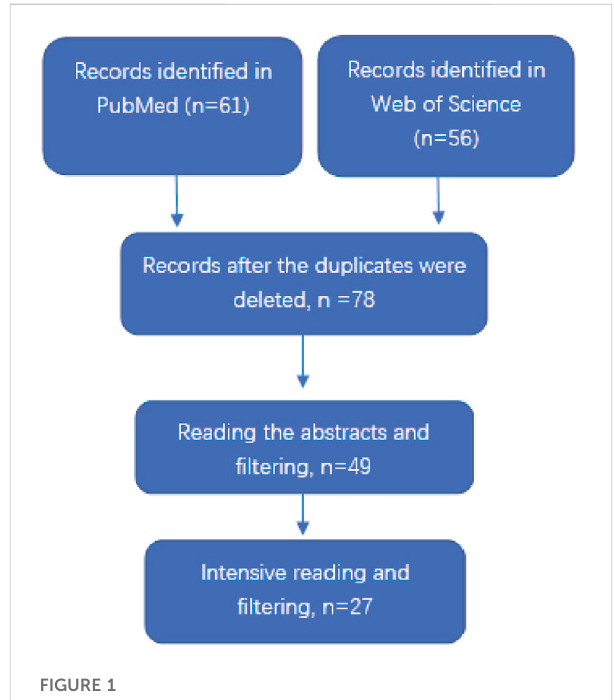
FIGURE 1 Flowchart of selection and screening of the